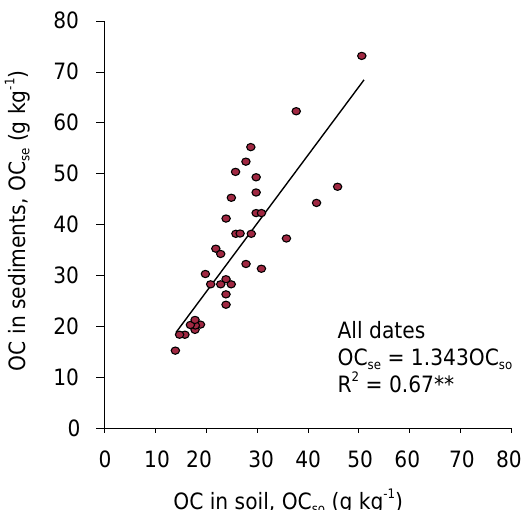
Figure 2. Relationship between total organic carbon (OC) contents in eroded sediments and in the 0-0.025 m layer of the soil, in a Humic Cambisol for 15 years under natural rainfall conditions. OC so : organic carbon in the soil; OC se : organic carbon in the